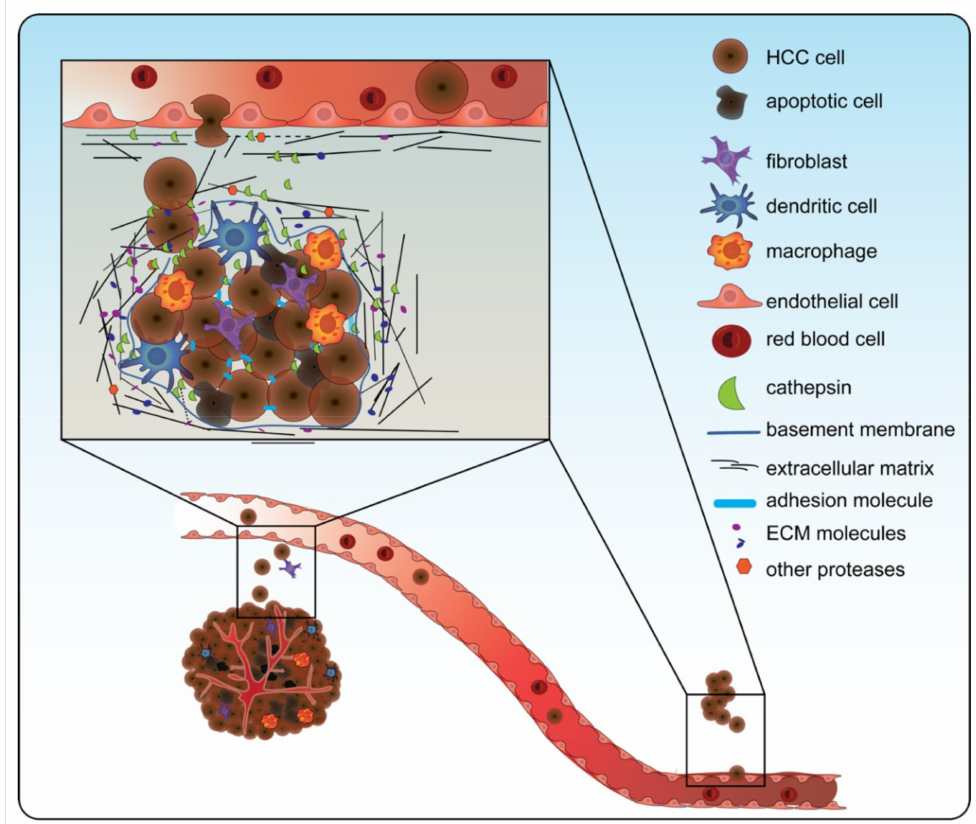
Figure 3. Cathepsins are involved in tumor invasion and metastasis. Cathepsins are involved in tumor invasion and metastasis by (1) going to the surface of the cancer cell or being secreted to activate other proteases such as matrix metalloproteases (MMPs) and urokinase-type plasminogen activator (uPAs); (2) cleaving the extracellular matrix (ECM) together with the other proteases; and (3) breaking the junctions between cells. In doing so, cathepsins contribute to the epithelial-to-mesenchymal transition, aiding in invasion through the ECM and entry into the blood vessel. Note: in this figure, CTSD, CTSB, CTSS, and CTSL are all depicted as one green symbol for ease of concept. In HCC, CTSB induced the invasion of a cohesive multicellular group of cells (col- lective invasion) in a 3D invasion in vitro (HepG2 and Huh-7 cells) model. In this